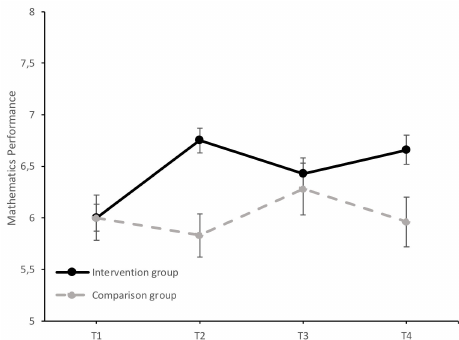
Figure 3. Evolution of the average MP scores ( ± SEM) in the intervention and comparison groups over time (T1 = baseline; T2 = at the end of the first year of intervention; T3 = follow-up after the first year of intervention; T4 = at the end of the second year of